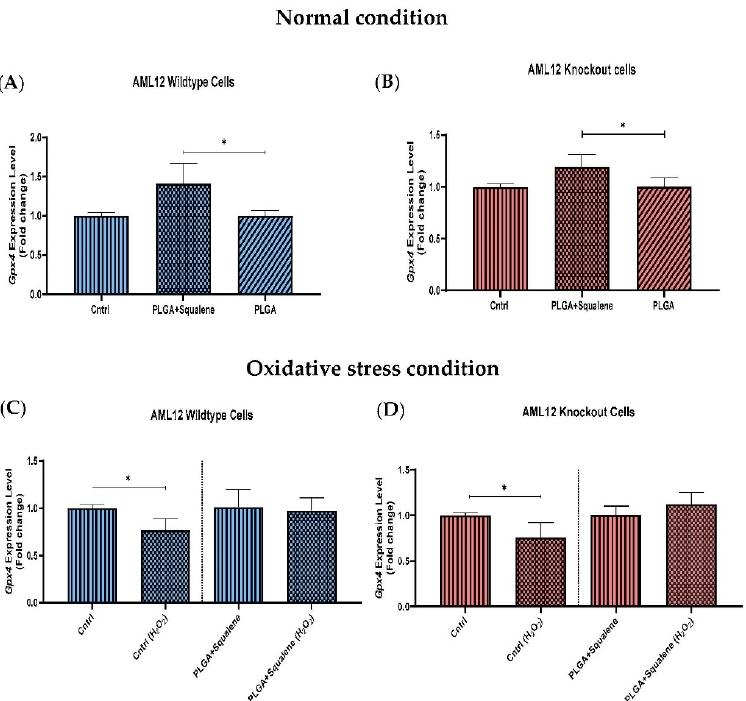
Figure 6. Effect of 30 µM PLGA based squalene nanoparticles on the Gpx4 gene expression